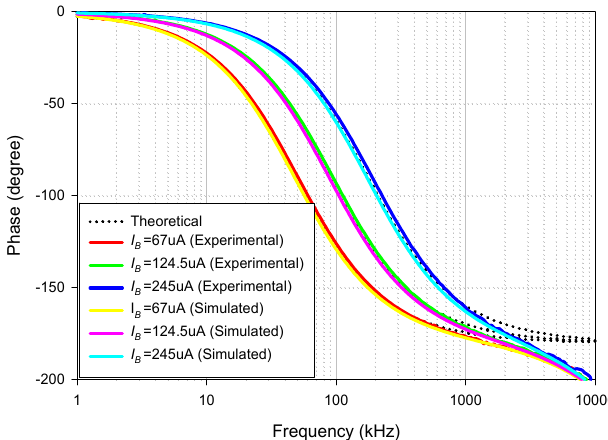
Figure 19. Frequency gain response of AP − with different I B values. The simulated AP − phase response with different temperature values ( − 40 °C, − 20 °C, 0 °C, 20 °C, and 80 °C) is shown in Figure 20 where R 1 and R f remained at 1.2 k Ω , I B = 124.5 μ A. The simulated results revealed that the temperature had little impact on the phase response of the proposed circuit, as expected in Table 2. Figure 21 shows the measured input and output waveform of AP − with different I B values (67 μ A, 124.5 μ A, 245 μ A) where the input signal amplitude was 20 mV p ‐ p .